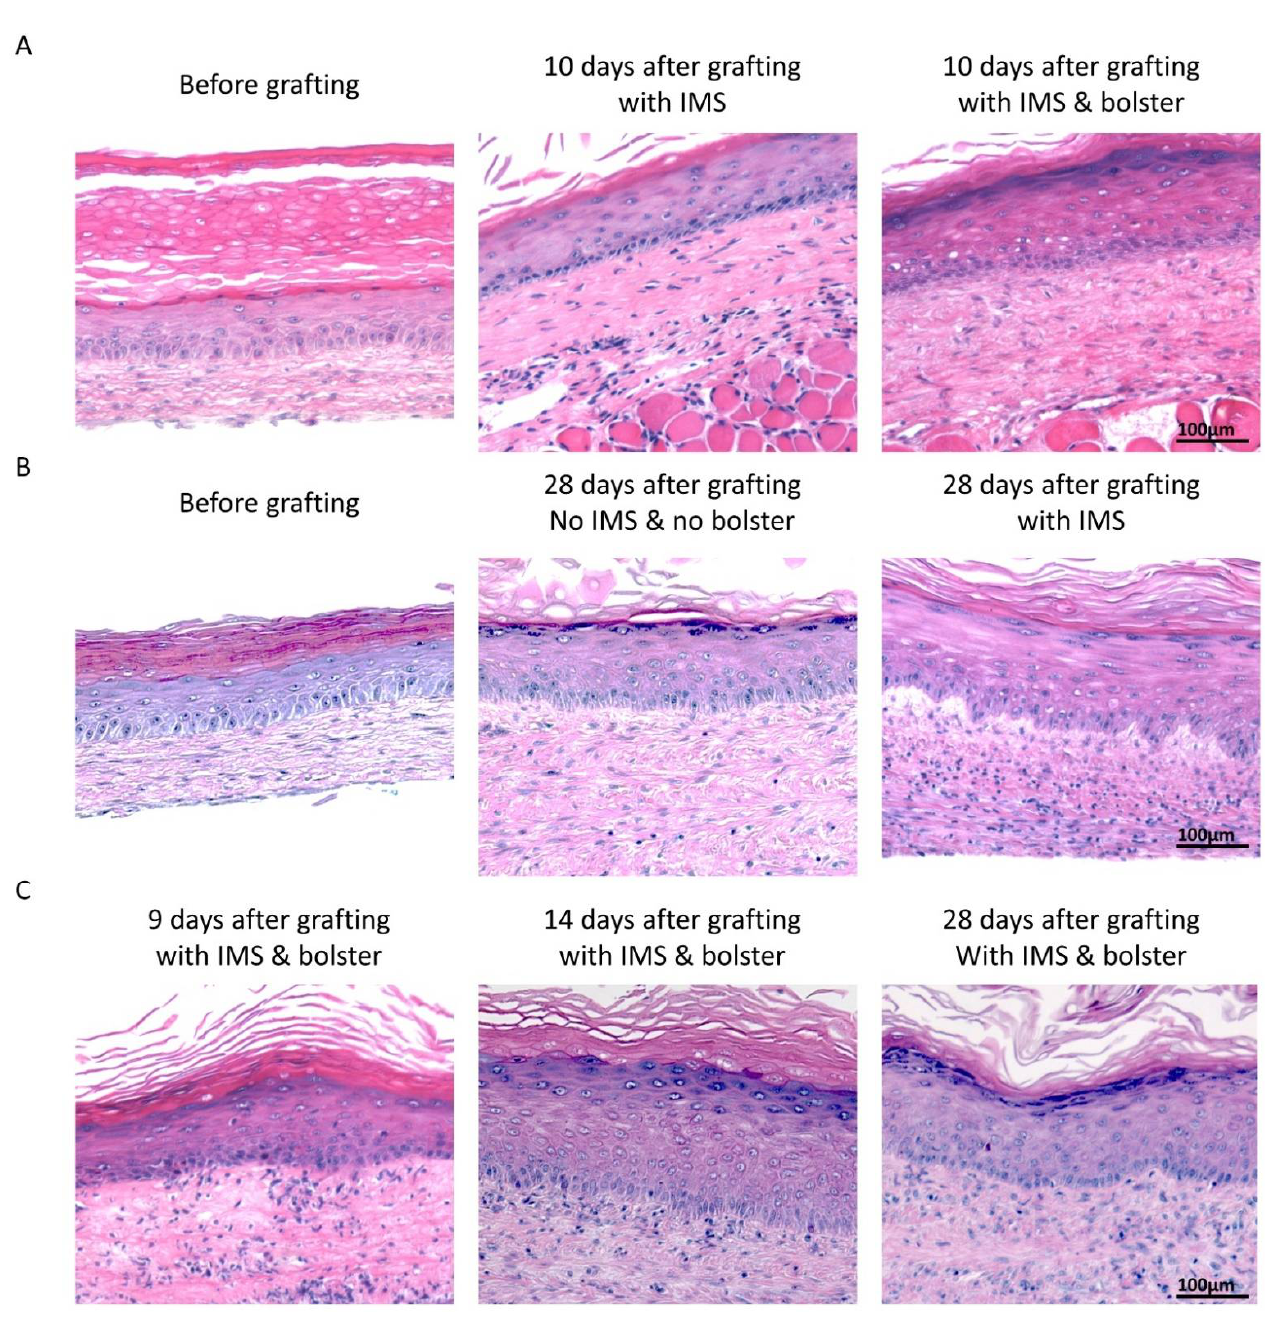
Figure 5. Hematoxylin and eosin staining of reconstructed skins after grafting. ( A ) SASSs were grafted with IMS or with IMS and a bolster and harvested after 10 days. ( B ) SASSs were grafted with the conventional method (no IMS and no bolster) or with both and harvested after 28 days. ( C ) SASSs were grafted with IMS and a bolster, and harvested at different time points (10, 14, and 21 days).